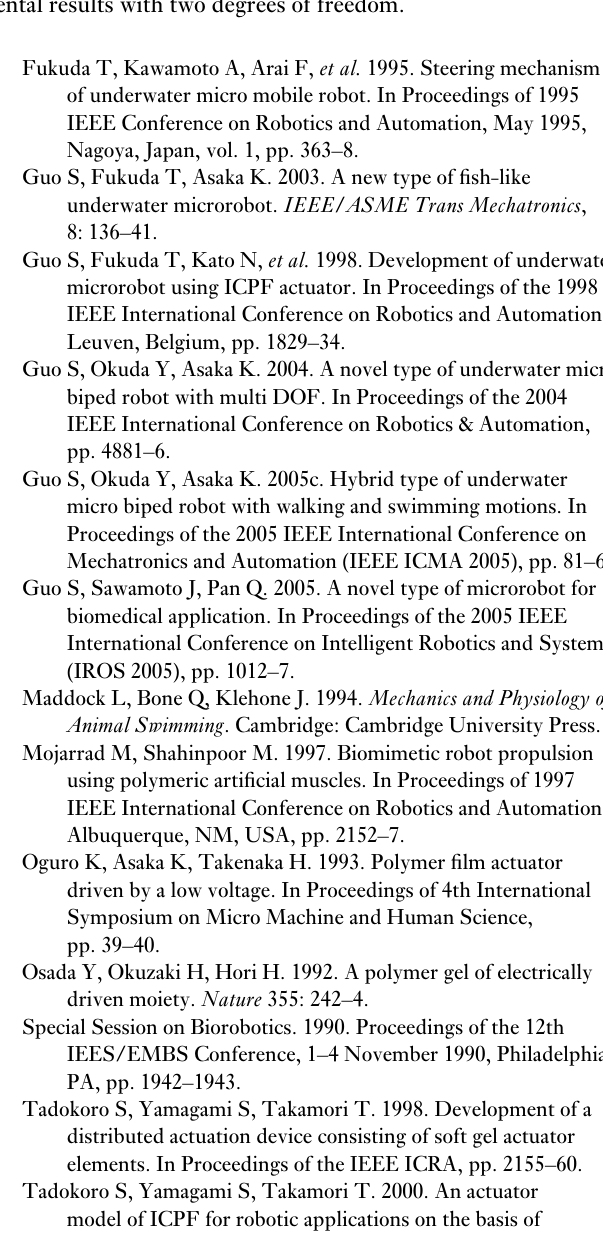
Figure 19 Relationship between calculation results and experimental results with two degrees of